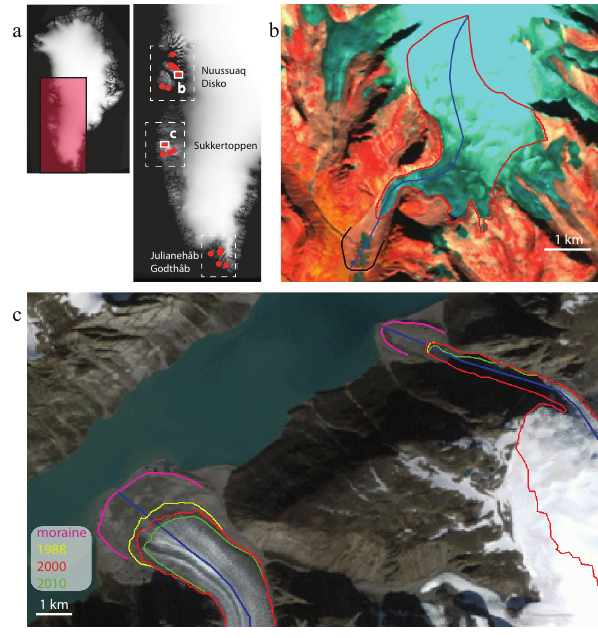
Fig. 1. (a) Location of the studied glaciers. White squares give the position of the images shown in (b) and (c) . (b) Glacier outlines in 2000 (red), flow line (blue), and maximum extent (black) of Saqqaq derived from Landsat imagery and DEM. Background is a false colour composite of the 2010 Landsat image. (c) Two examples, Serminnguaq (left) and Sissarissut (right), of frontal retreat mea- sured from 3 Landsat images in 1988, 2000, and 2010. Background image is a colour composite of the 2000 Landsat